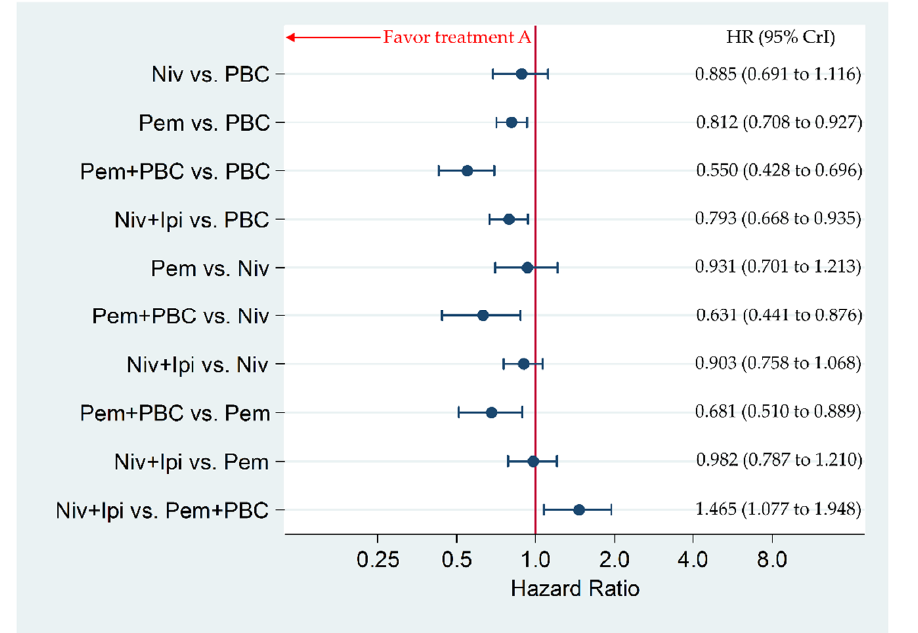
Figure 5. Comparative efficacy for overall survival (OS) among the five therapeutic regimens (Niv+Ipi, Pem+PBC, Pem, Niv, and PBC) in patients with programmed cell death ligand 1 (PD-L1) expression levels of 1% or more. Comparisons were expressed as Treatment A versus Treatment B. Data are expressed in terms of hazard ratio (HR) and 95% credible intervals (CrIs); Niv, nivolumab; PBC, platinum-based chemotherapy; Pem, pembrolizumab; Ipi,